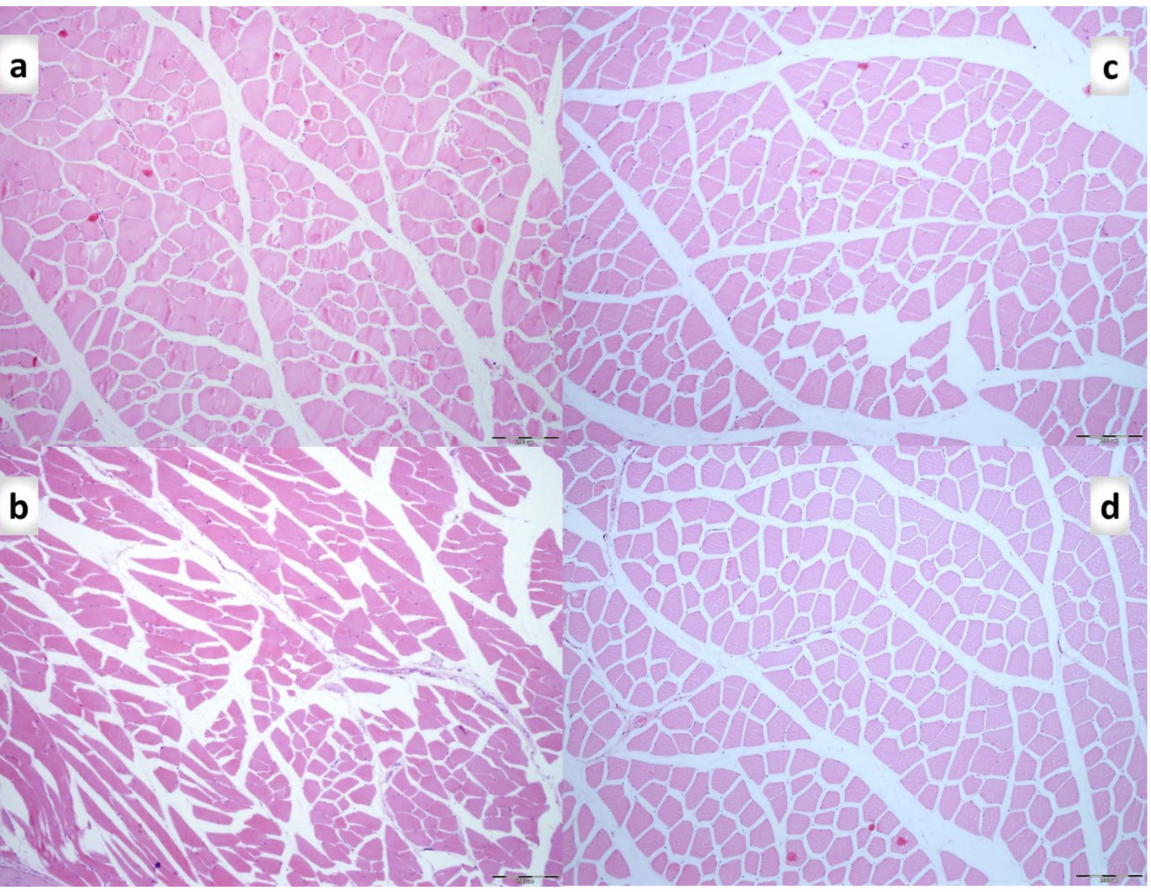
Figure 13. Hematoxylin and eosin-stained cross-sections of the quadriceps muscle. ( a ). Control rats at day 28 ( b ). Control rats at day 42. Smaller fiber areas can be appreciated at day 28, and more diffuse smaller fiber areas found at day 42 compared to the BPC 157 group at day 28 ( c ) and day 42 ( d ) of injury. Magnification × 100. Scale bar is 200 µ m. On the 42nd day, morphologic features were constant in both groups compared to those on the 28th day. In the control group, a proliferation of fibroblasts and fibers as well as fibers maturation was present but still not so prominent compared with the BPC157 group, and their orientation was still not optimal due to the long axes of the myofibers close to the myotendinous junction. Continuous muscle atrophy